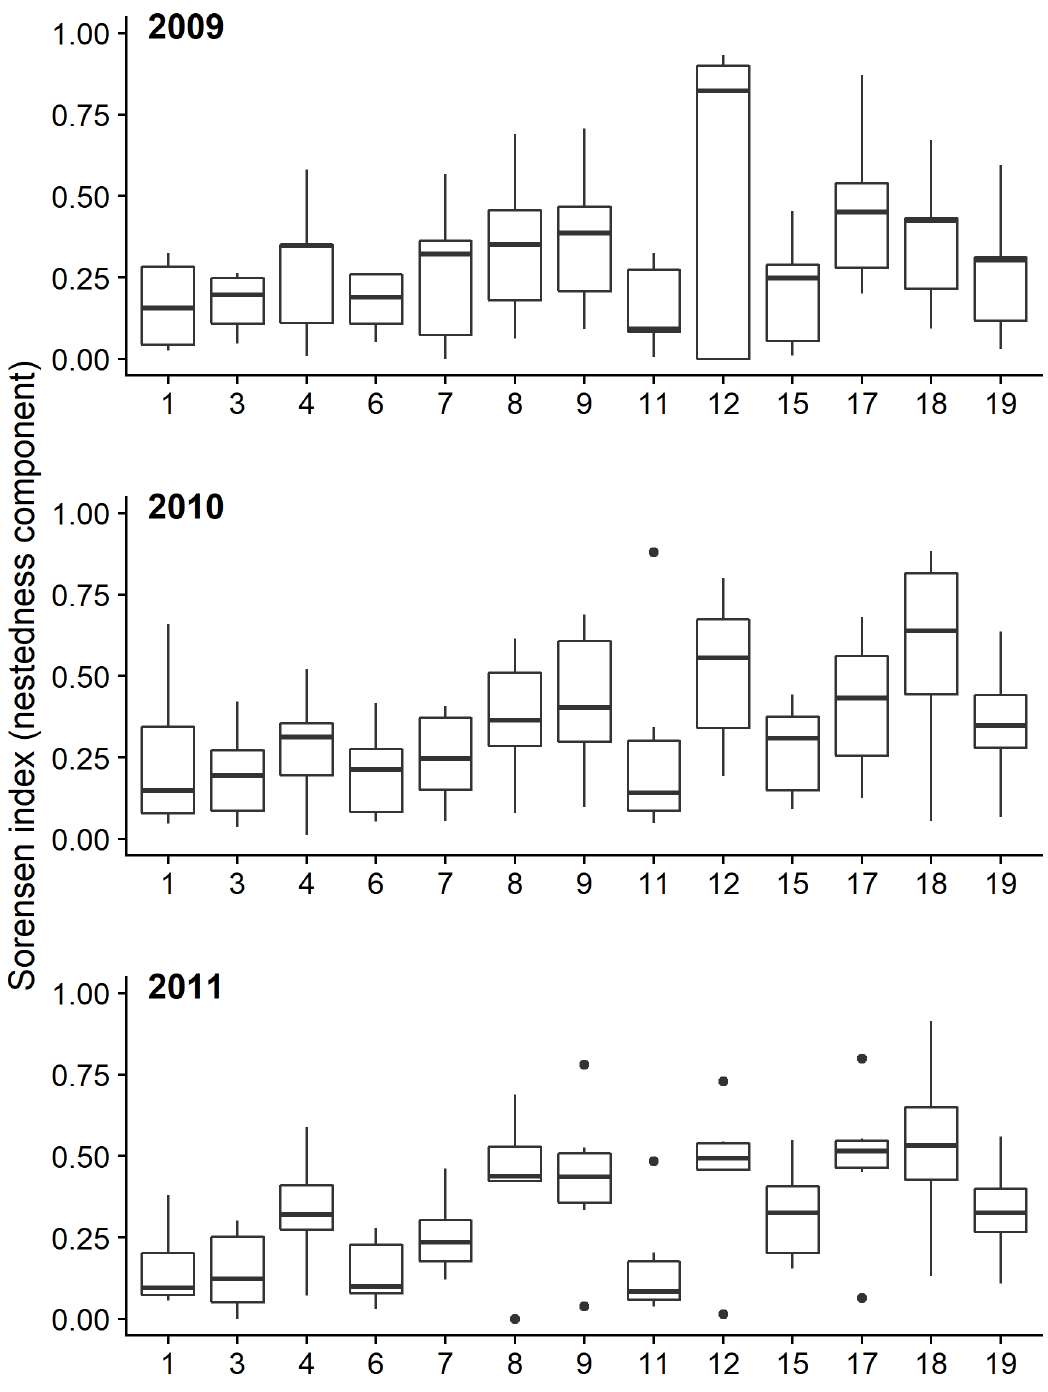
Fig 3. Boxplots showing the extent to which bird communities in each of the thirteen artificial wetlands are nested subsets of the communities in natural wetlands, as measured using the Sorensen index for each of the three years separately. The numbers on the x-axis correspond to the numbers of the artificial wetlands in Table 1. Each boxplot is made using six data points, representing the nestedness between each artificial wetland and the six natural wetlands. The higher the value the higher the degree of nestedness. Boxplots are based on the median and the 1 st and 3 rd quartiles. Outliers represent the points that extend beyond 1.5 times the interquartile range.